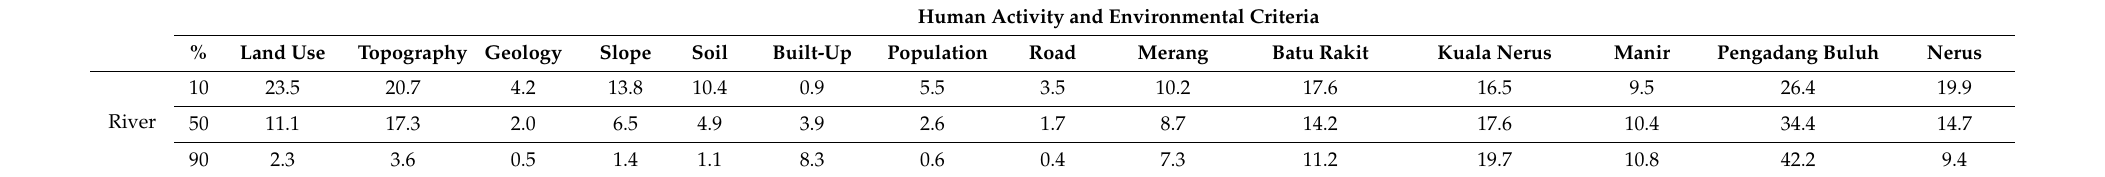
Table 3. Coastal city vulnerability sensitivity